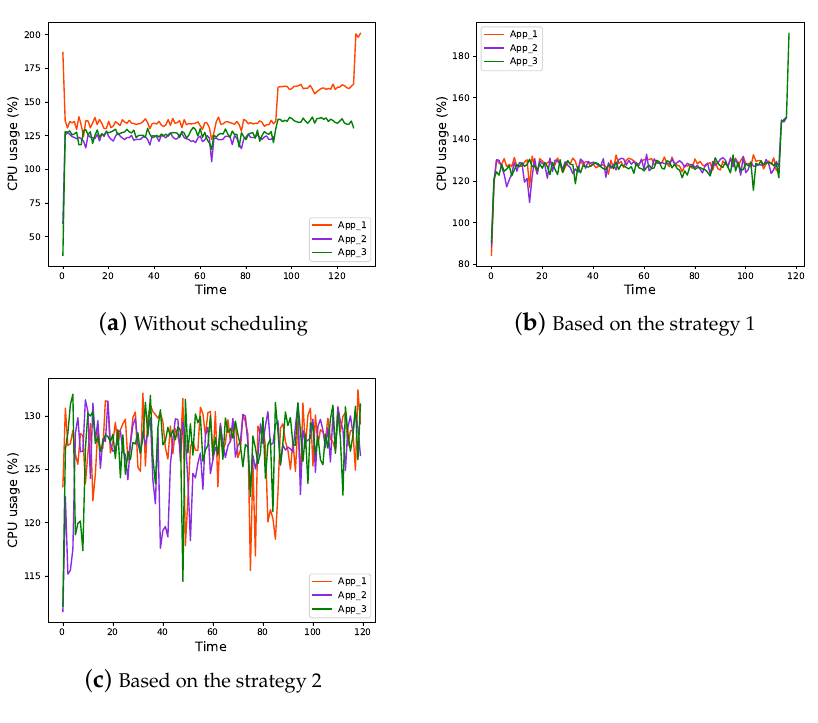
Figure 14. CPU usage of each